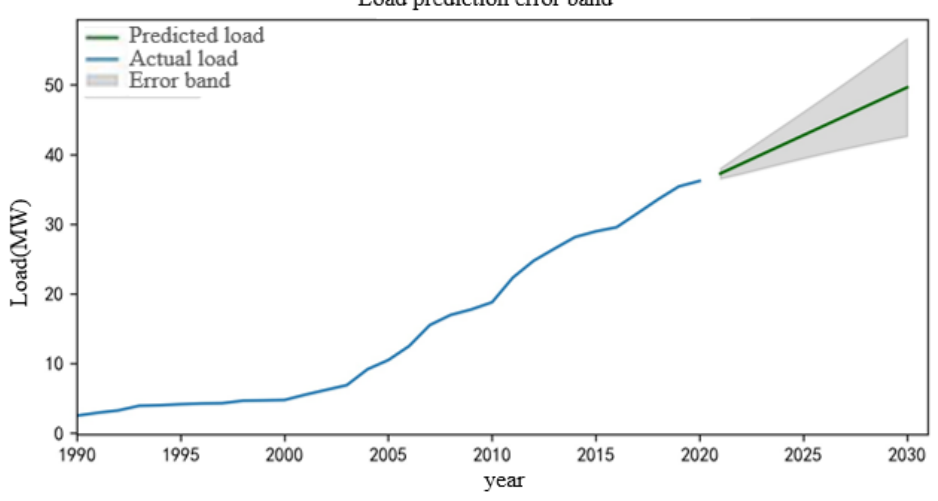
Figure 10. Initial load prediction results.